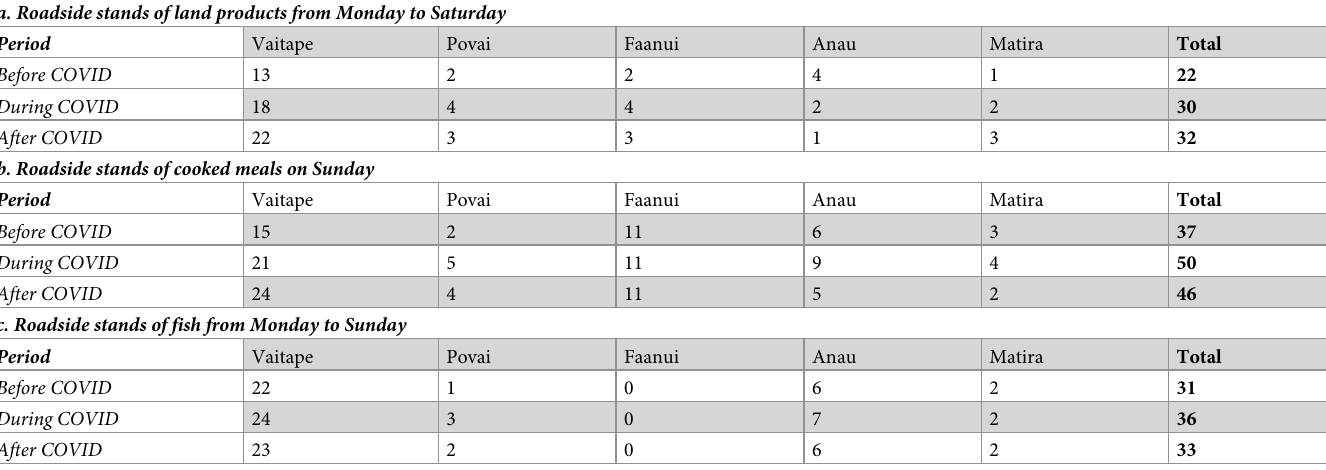
Table 1. Number of roadside stalls as a function of food products sold in each district of Bora-Bora and its evolution.